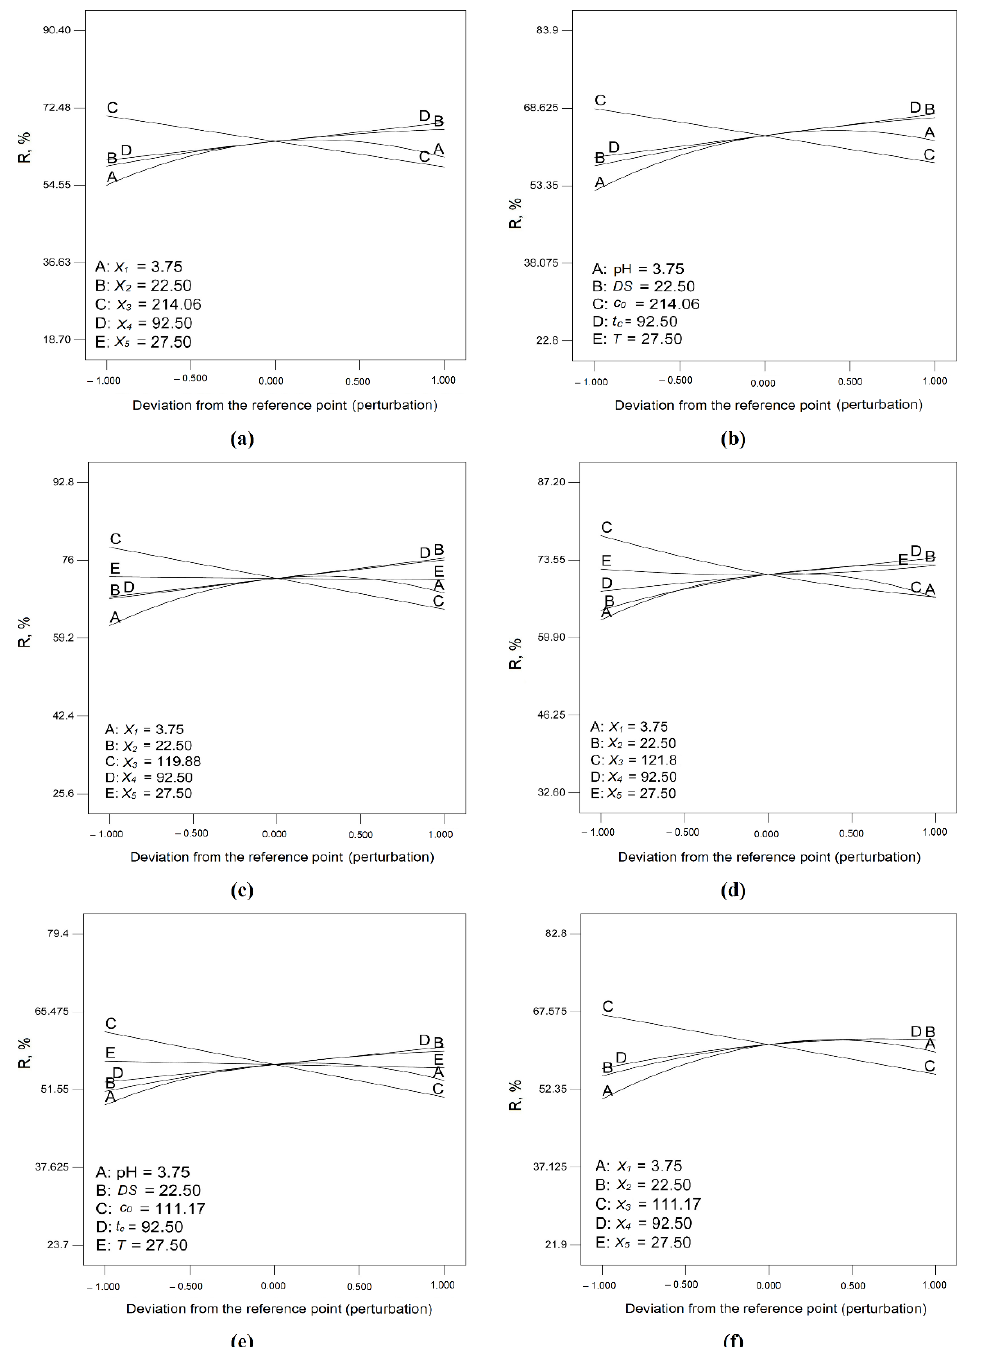
Figure 11. Perturbation diagrams resulting from the sensitivity analysis for the mathematical models developed for biosorption efficiency of heavy metal ion on soybean biomass and soybean waste biomass (the meaning of the notations ( a – f ) is the same as those from Figure 9).